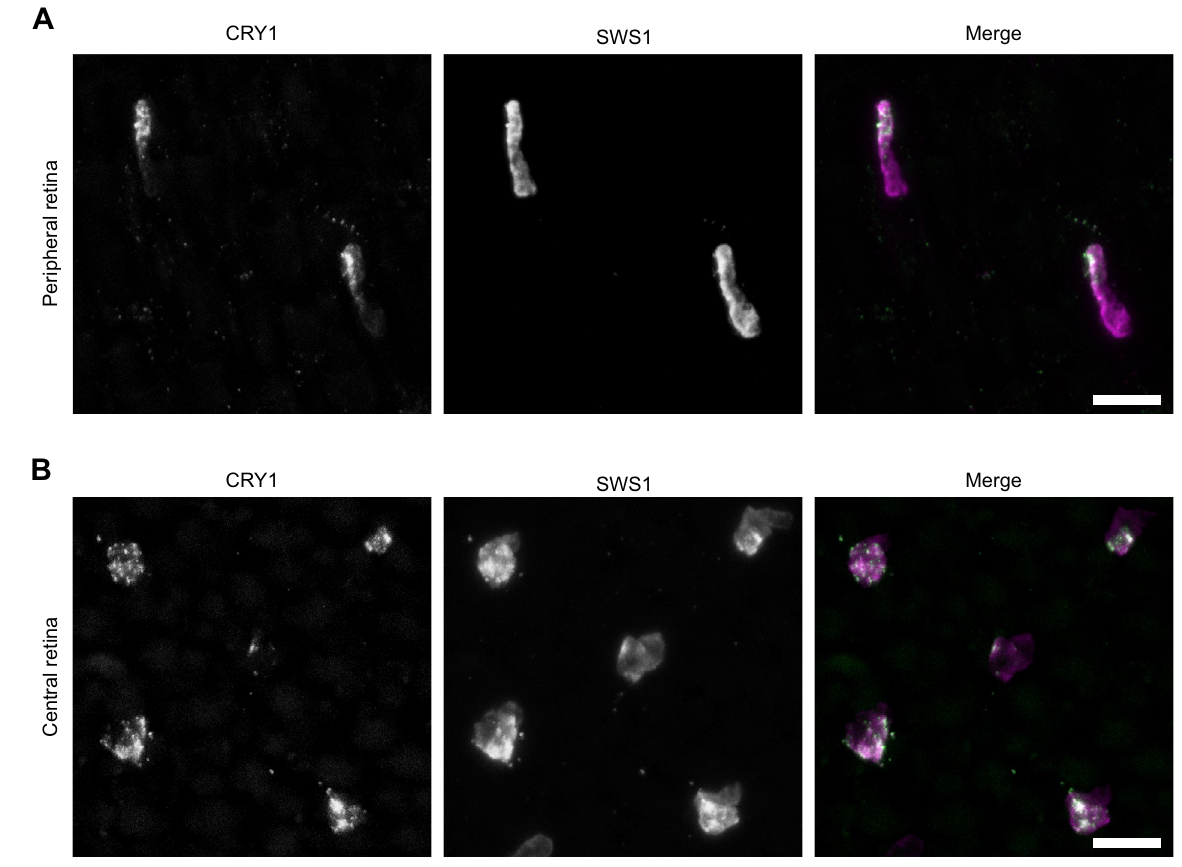
Figure 3. Outer segments of the zebra finch UV cones in a whole mount retina. ( A ) Outer segments of photoreceptors in the peripheral retina. They appear bent and elongated because of the low density of photoreceptors and the absence of pigment epithelium, which, when present, helps to keep them straight. The signal from CRY1 appears only at the tip of the outer segment (first panel), while the UV opsin is visible across the full length of the outer segment (second panel). ( A ) Outer segments of the photoreceptors in the central retina. Here, the photoreceptors are not bent, because their high density keeps them packed and straight despite the absence of pigment epithelium. The merged images are coloured as in Fig. 1. Bar 10